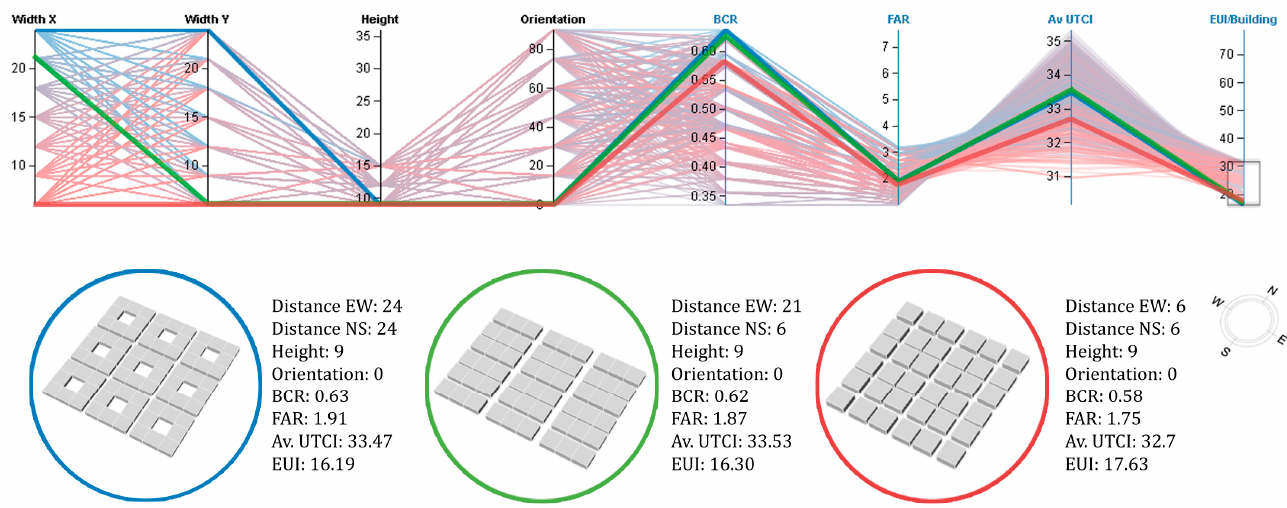
Figure 11. Parallel coordinates showing the selective cases for the minimum EUI. Figure 12 depicts the optimum case in each typology achieving moderate heat stress ters to attain EUI lower than ~32 kWh/m 2 which is only ~40% of the highest consumption AV.UTCI of <32 as well as the lowest 40% EUI. The optimum cases tend to have lower recorded. Courtyards and linear forms dominated the objective space for EUI; however, the common features of low energy urban forms are the same in all typologies; higher BCR and lower FAR are the most predominant (Section 3.3.), followed by orientating blocks to the South. Despite the large number of design parameters that bring forth the lowest 40% EUI, cases with lower building heights and BCR bring about higher AV.UTCI due to the lack of shadowing on streets. Our results are partially congruent with the recommendations of Olgyay in [18] and Dekay and Brown in [31] for hot-arid regions. The latter,